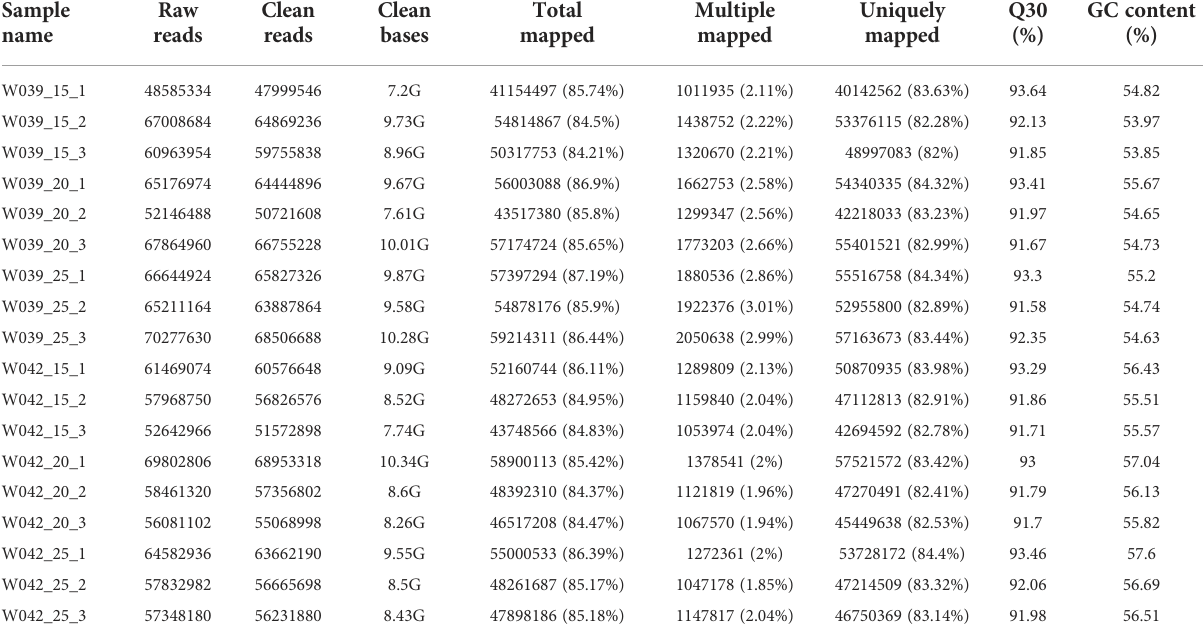
TABLE 1 Summary of transcriptome analysis results for pericarps of inbred lines W039 and